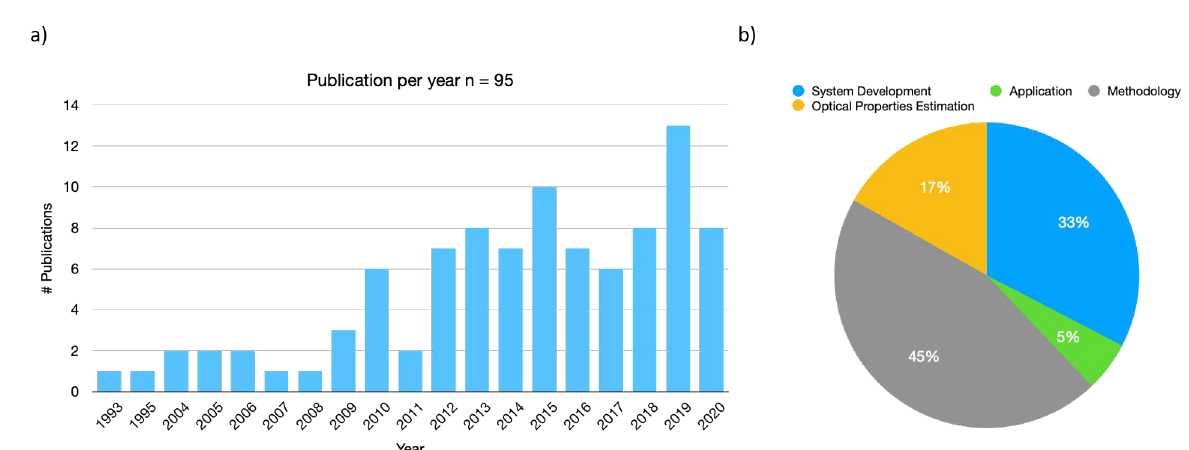
Figure 4. Summary of the literature review results. ( a ) Graph showing the number of publications using SCL in biomedical diffuse optics since the first study in 1993. ( b ) Summary of the main focus of the papers